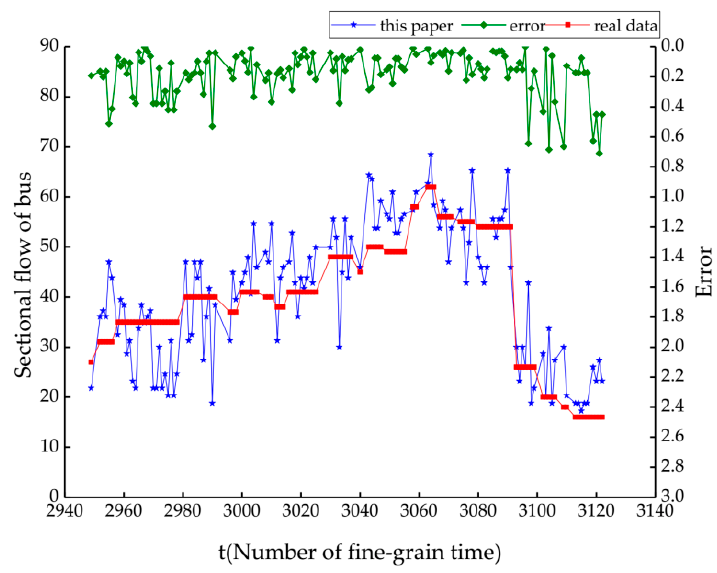
Figure 13. The results of the proposed method.